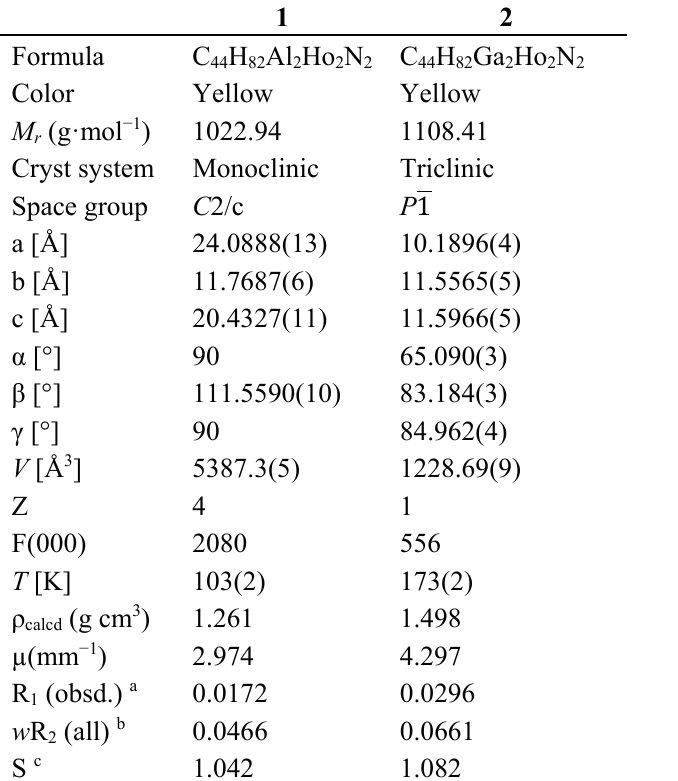
Table 3. Crystallographic data for compounds 1 and 2